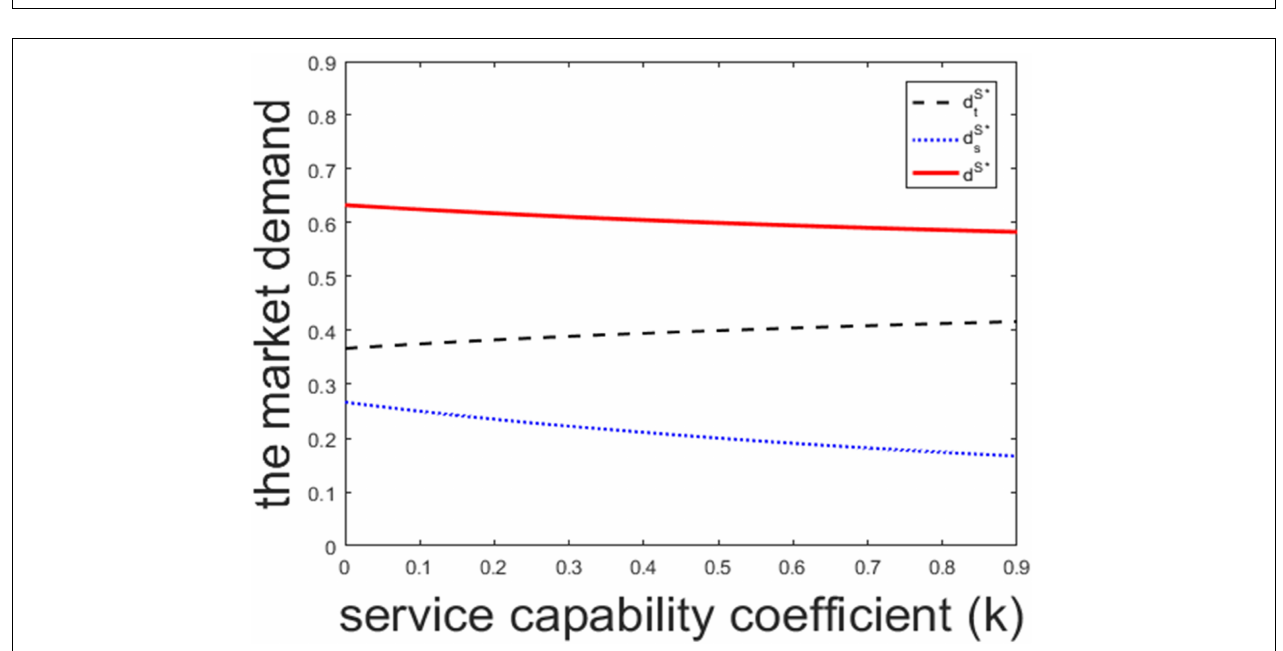
FIGURE 3 | The market demand with surplus-value.